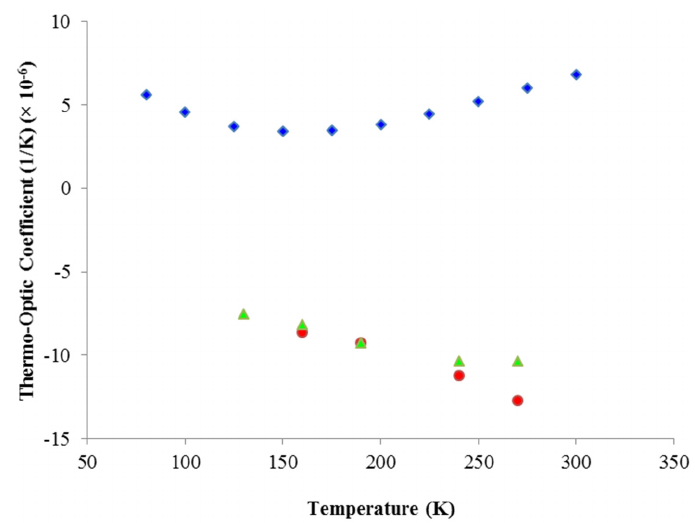
Figure 31. Thermo-optic coefficient as a function of absolute temperature for the YSO b -axis (blue) [30], undoped CaF 2 (red) [59], and unspecified Yb-doped CaF 2 (green) [59]. YSO was measured at a wavelength of 1064 nm and CaF 2 measurements were at 632.5 nm.